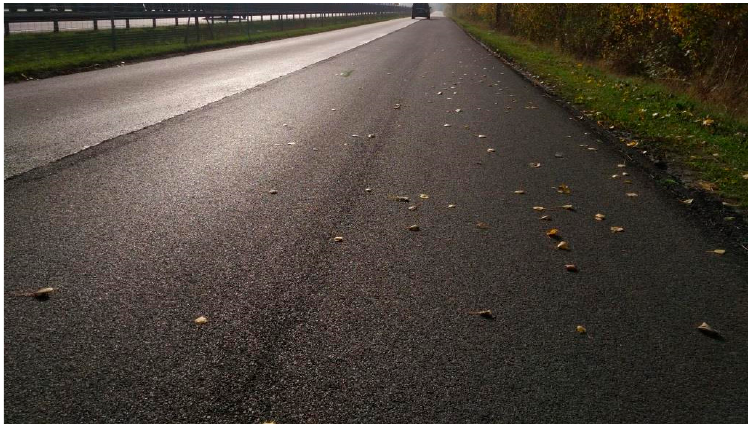
Figure 9. First long test section (D)–D ą brówka, June 2019.